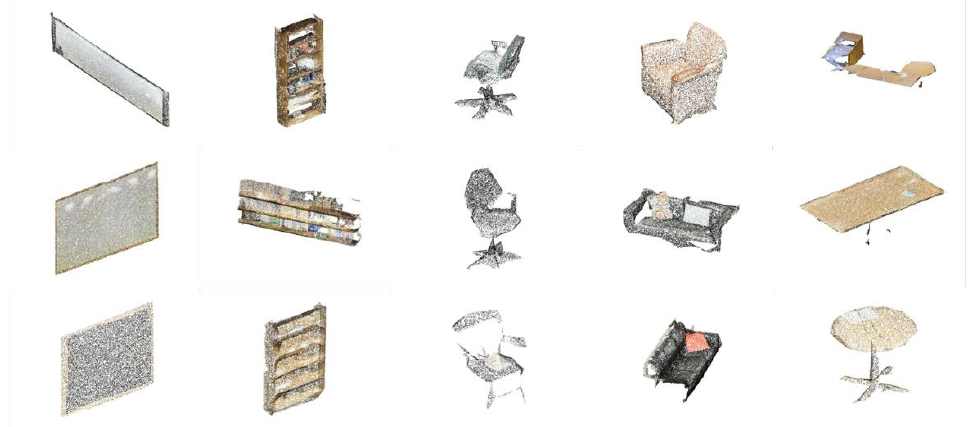
Figure 5. Samples correctly classified by the trained InceptionV3 with 10% of point cloud samples in training set and with online images in the validation